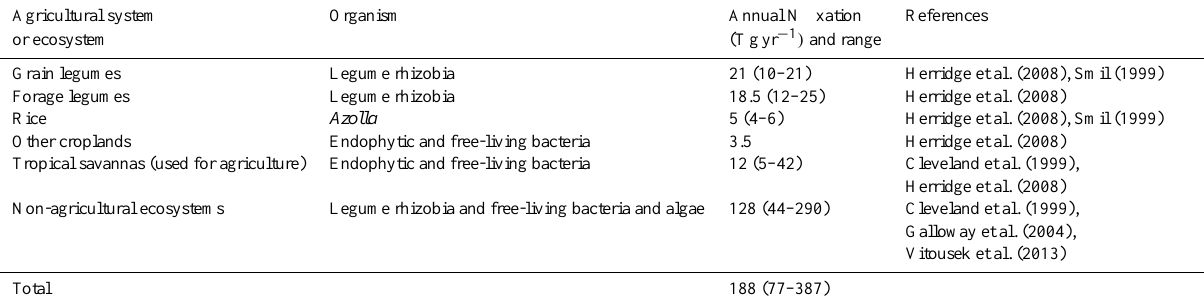
Table 1. Global terrestrial contributions to biological N fixation in 2000. Values inTgN per year with the range of estimates in brackets. Agricultural